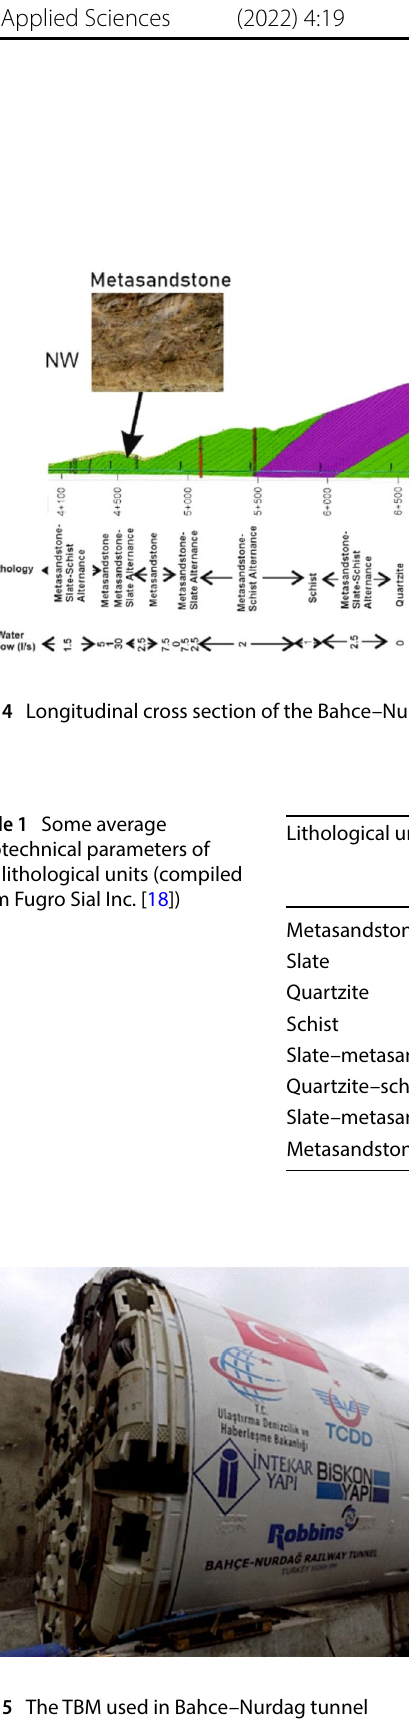
Fig. 5 The TBM used in Bahce–Nurdag tunnel Fig. 6 The conveyor belt system of the